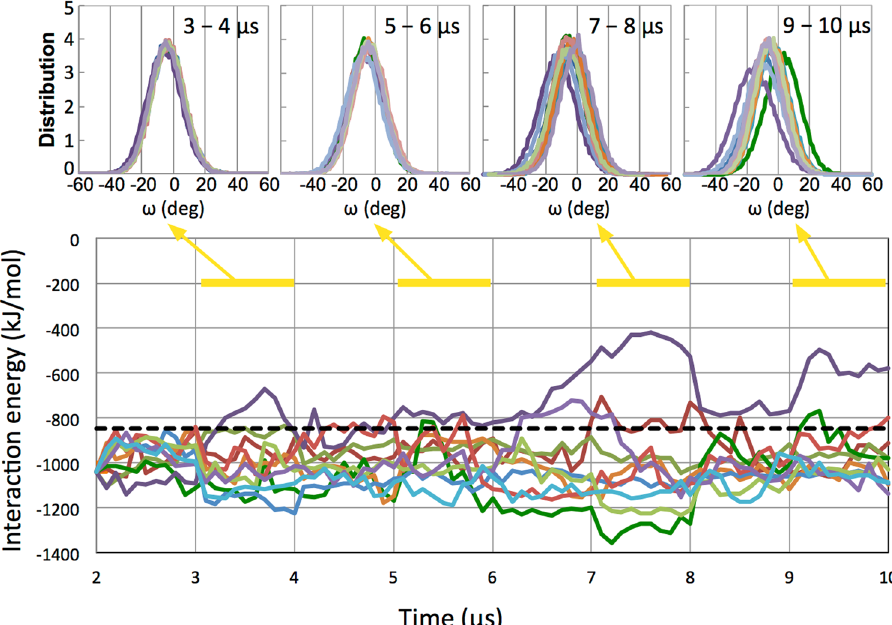
Figure 4. Distribution of ω angle and interaction energy between EPR and 9E5 over 10 μ s. (Top) Normalized distribution of the omega angle of Pro 103 in the heavy chain over the time intervals of 3–4, 5–6, 7–8, and 9–10 μ s. The normalized distribution was computed as follows: the omega angle was measured for each snap shot. Then, the number of each omega angle (bin width of 1 degree) was determined, and finally, this number was divided by the total number of snap shots. (Bottom) Interaction energy between EPR and 9E5. The dashed line indicates the corresponding average value for the four trans-complex trajectories over 2 to 10 μ